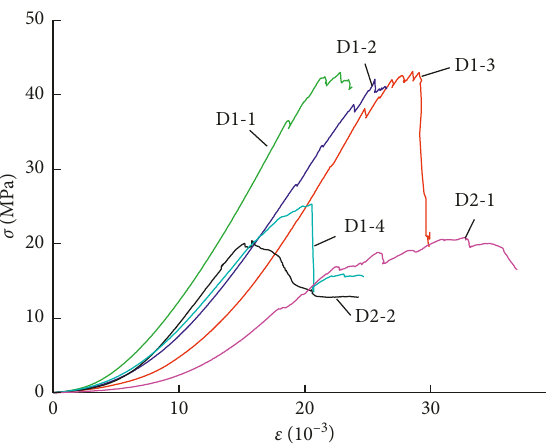
Figure 3: Static stress-strain curves for water-saturated coal specimens.